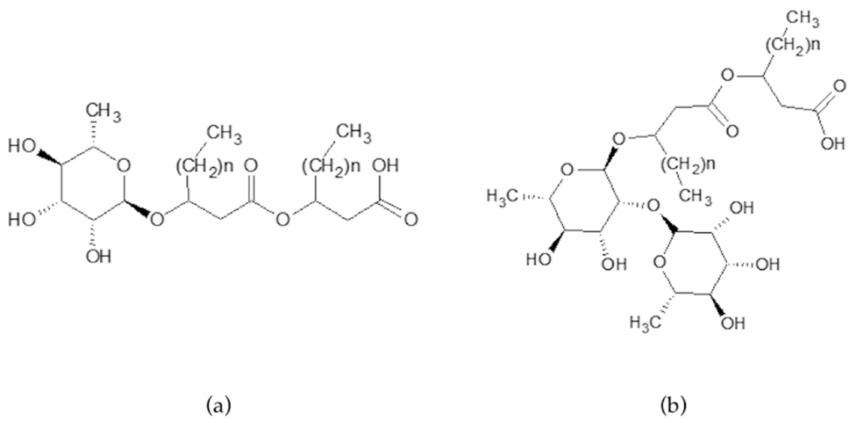
Figure 1. Structure of mono-rhamnolipids ( a ) and di-rhamnolipids ( b ); n = 4–8 methylene group for a chain length of